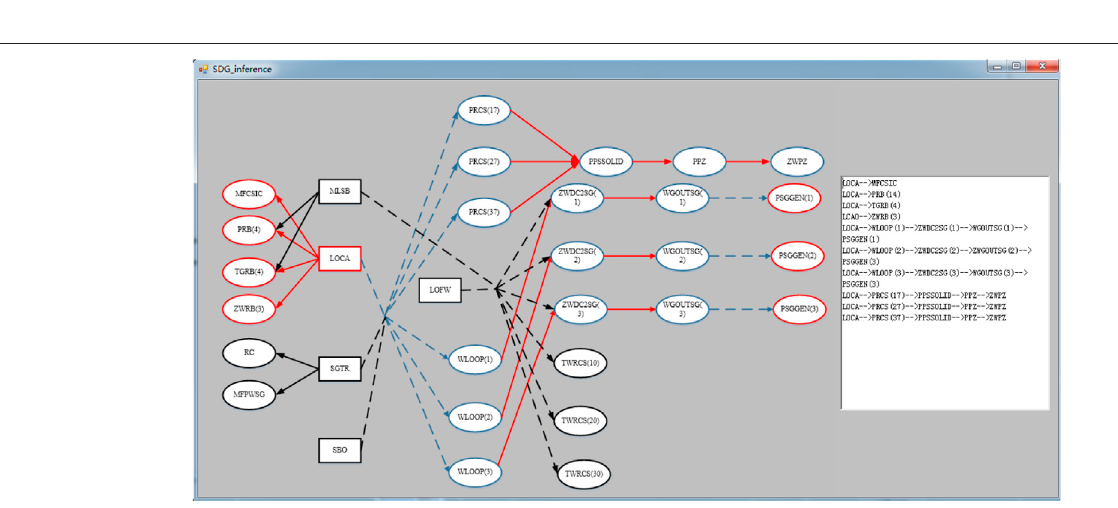
FIGURE 13 | Interface of SDG inference at the time the LOCA